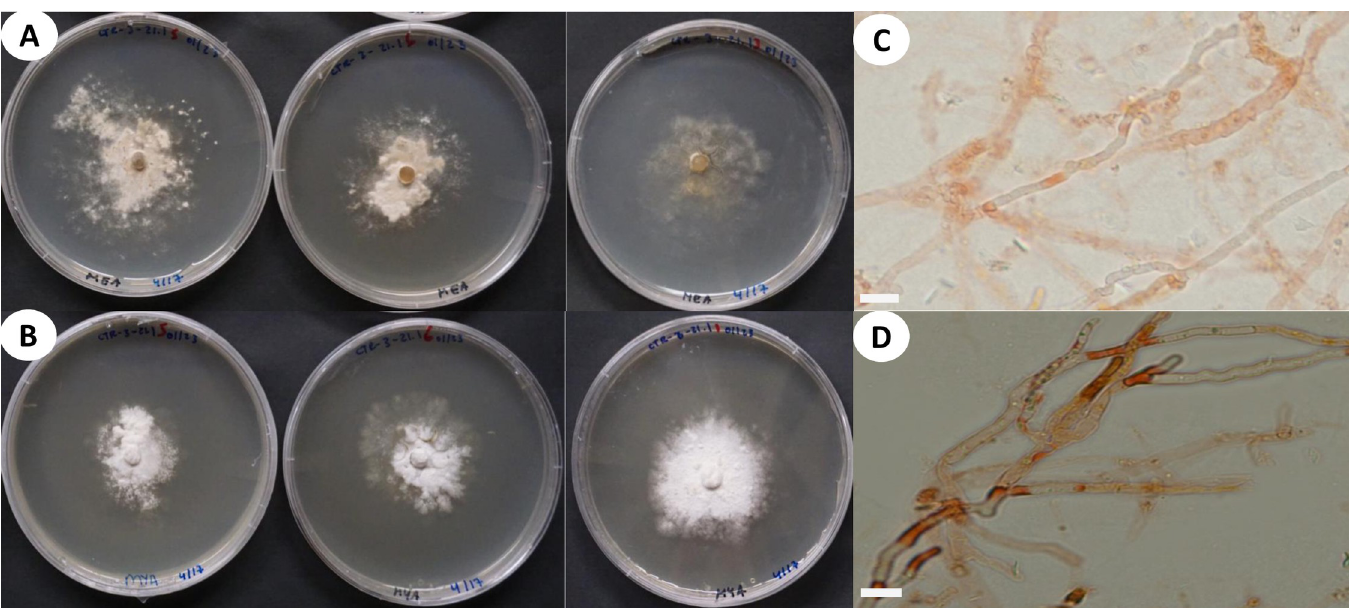
Fig 17. Cultural characteristics and microscopical features of P . taromenane . A. Macromorphology of colonies on MEA. B. Macromorphology of colonies on MYA. C-D Slightly branched sections of hyphae from white mycelium with simple septa and clamp connections (Red Congo). Scales bars = 10 μ m.